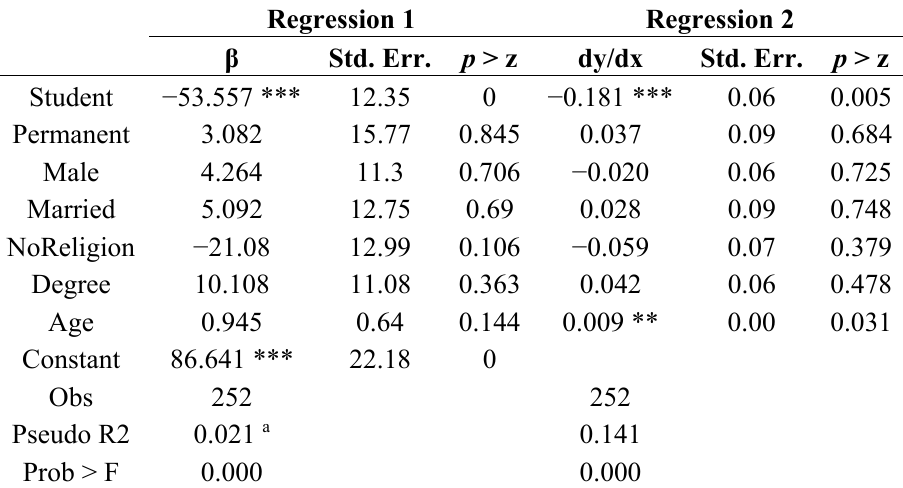
Table 2. Regression analysis (Dictator